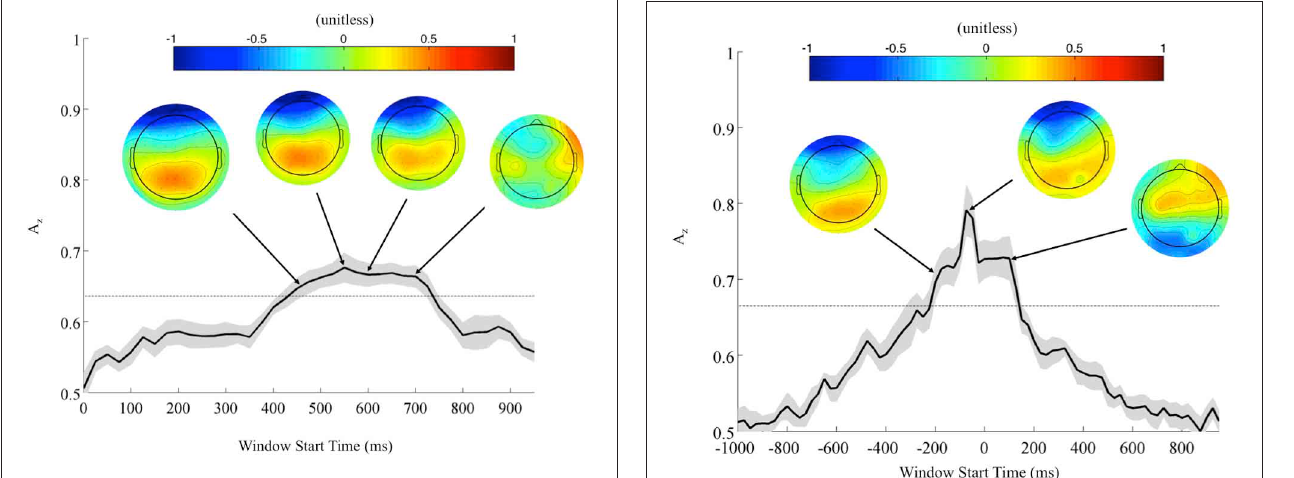
FIGURE 5 | Mean (black) and standard error (gray shading) response-locked leave-one-out discrimination performance across all subjects. As opposed to the stimulus-locked leave-one-out analysis across subjects, we find a response-locked significant common window leading up to the decision and tapering off after it has been made (Bonferroni corrected, p < 0 . 01). Normalized forward models across subjects at indicated times show the progression of discriminating scalp activity, with higher values indicating target discrimination and lower values indicating standard